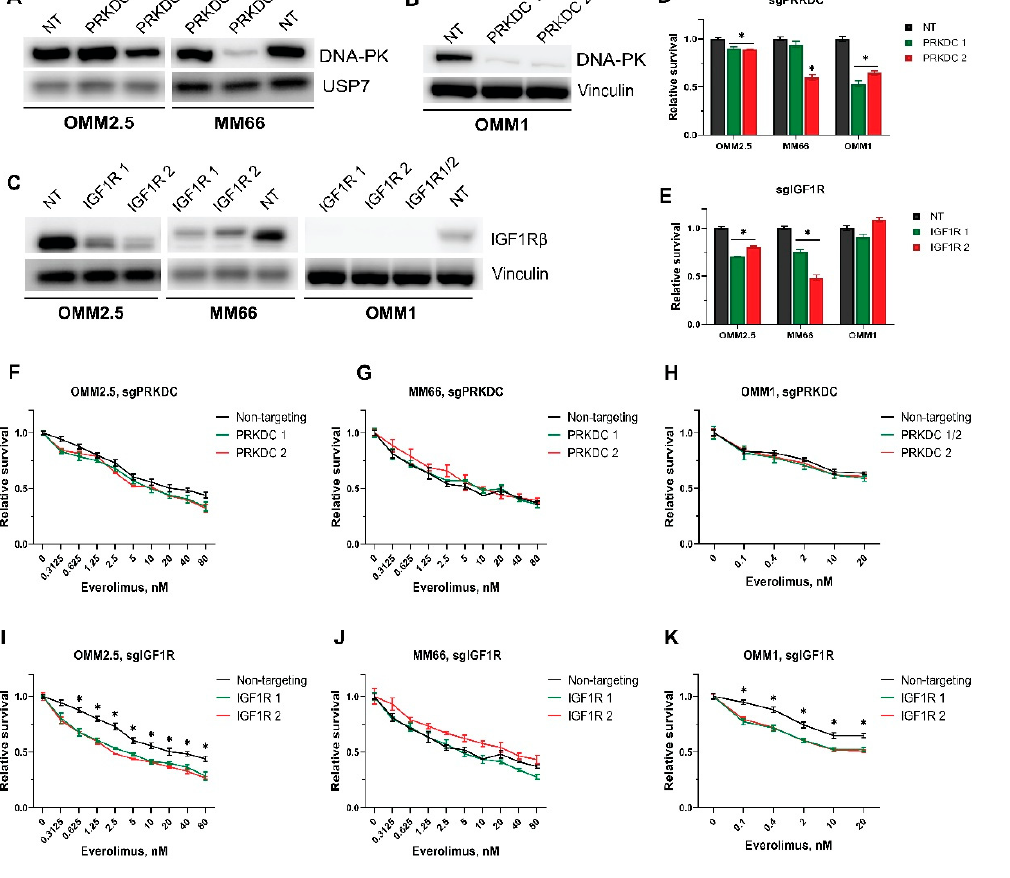
Figure 6. Effect of everolimus in combination with genetic depletion of either PRKDC or IGF1R on survival of UM cell lines. (A-B) Reduction of DNA-PKcs protein level upon genetic depletion of PRKDC by sgPRKDC 2 in OMM2.5 and MM66 cell lines ( A ) or OMM1 ( B ). NT: Non-targeting sgRNA, PRKDC 1, 2: sgRNAs targeting PRKDC . ( C ) Reduction of IGF1R protein level upon genetic depletion of IGF1R in OMM2.5, MM66, and OMM1 cell lines. NT: Non-targeting sgRNA, IGF1R 1, 2: sgRNAs targeting IGF1R . ( D , E ) Effect of PRKDC knockout ( D ) or IGF1R knockout ( E ) on viability of the